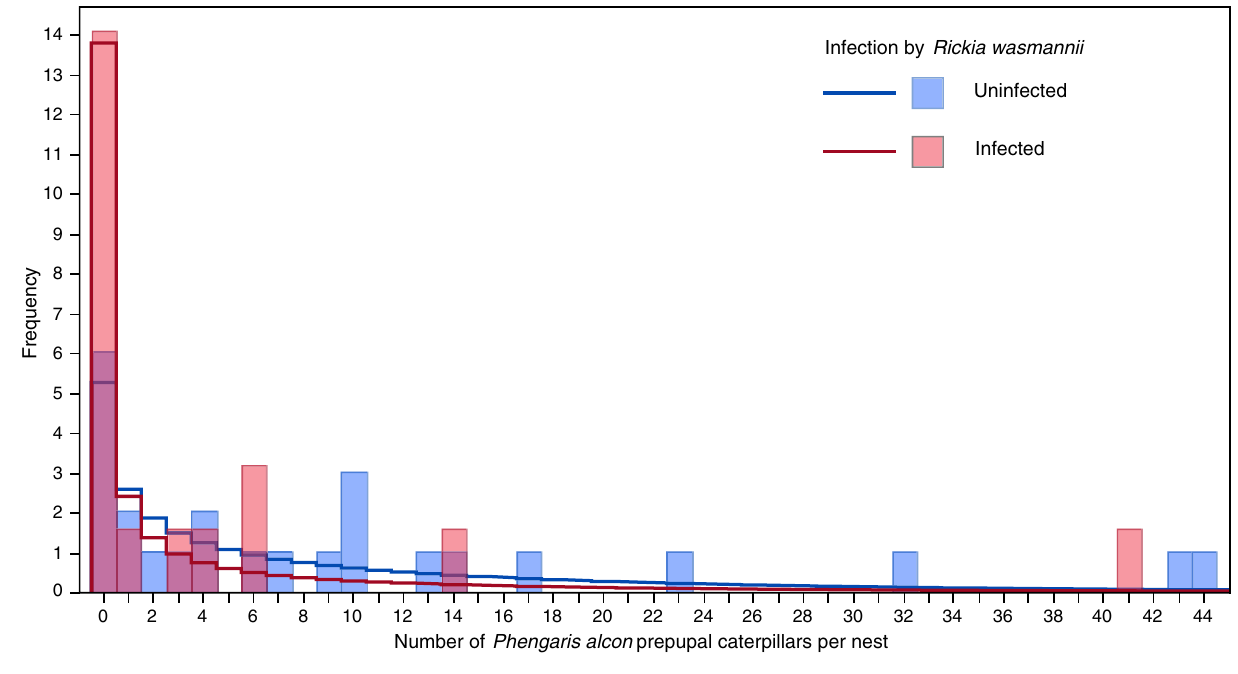
Figure 8. Histograms showing the distribution of number of prepupal caterpillars of Phengaris alcon in nests of Myrmica scabrinodis that are either infected by Rickia wasmannii (red bars) or uninfected (blue bars). Superimposed on the histogram are the fitted negative binomial probability density plots for infected (red line) and uninfected (blue line)